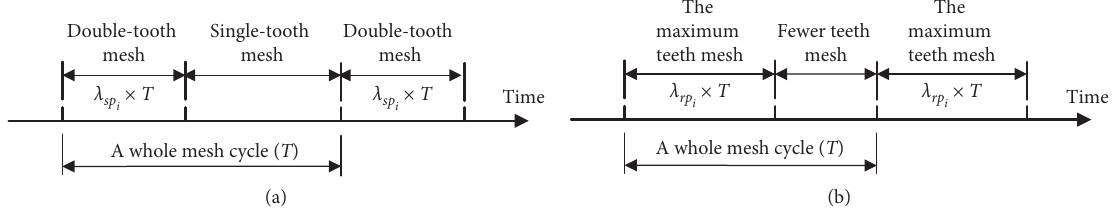
Figure 5: Meshing progress of one mesh cycle for the (a) external-external gear mesh and (b) internal-external gear